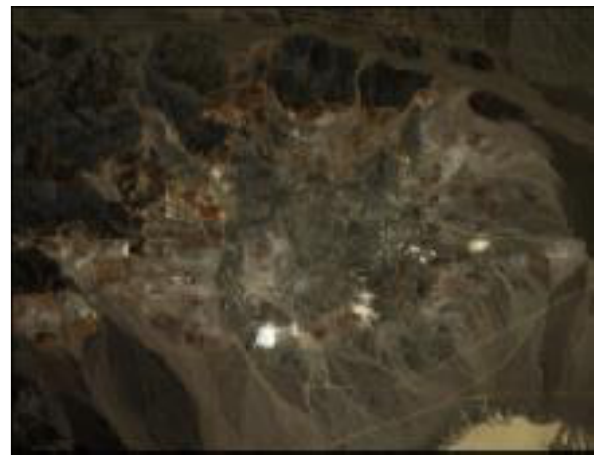
Figure 14. False-color image of cuprite.